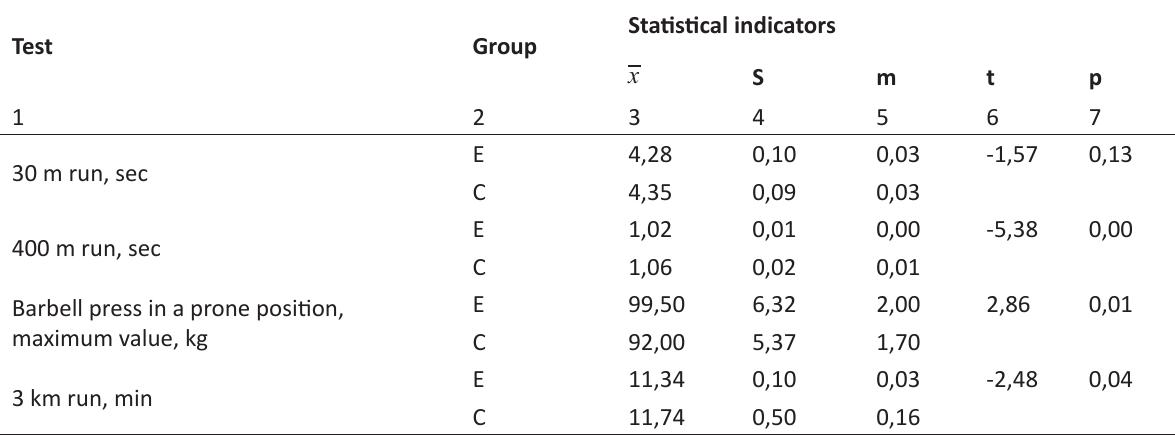
Table 4. The indicators of physical fitness of young rugby players of the experimental (n = 10) and the control (n = 10) groups after carrying out the